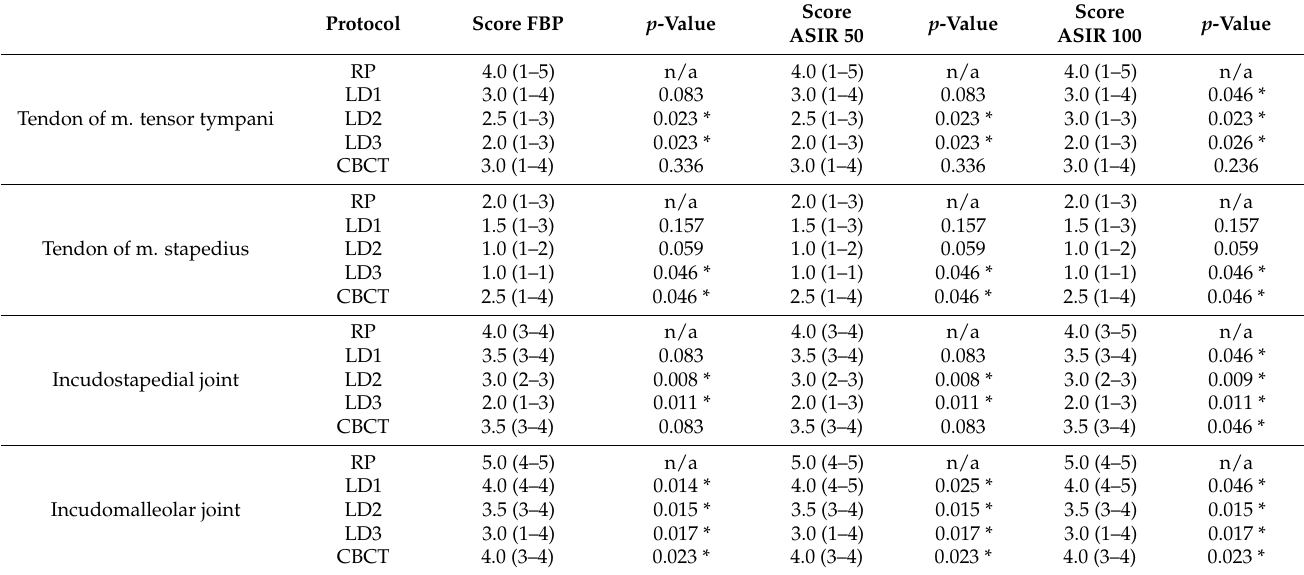
Table 4. Median score and range